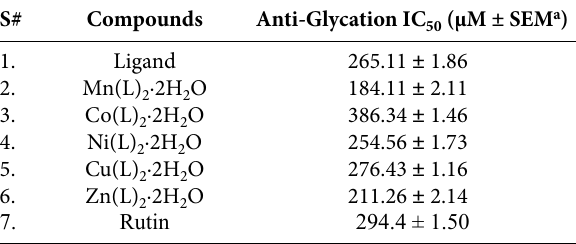
Table 1. Anti-glycation Activity of Ligand and Respective